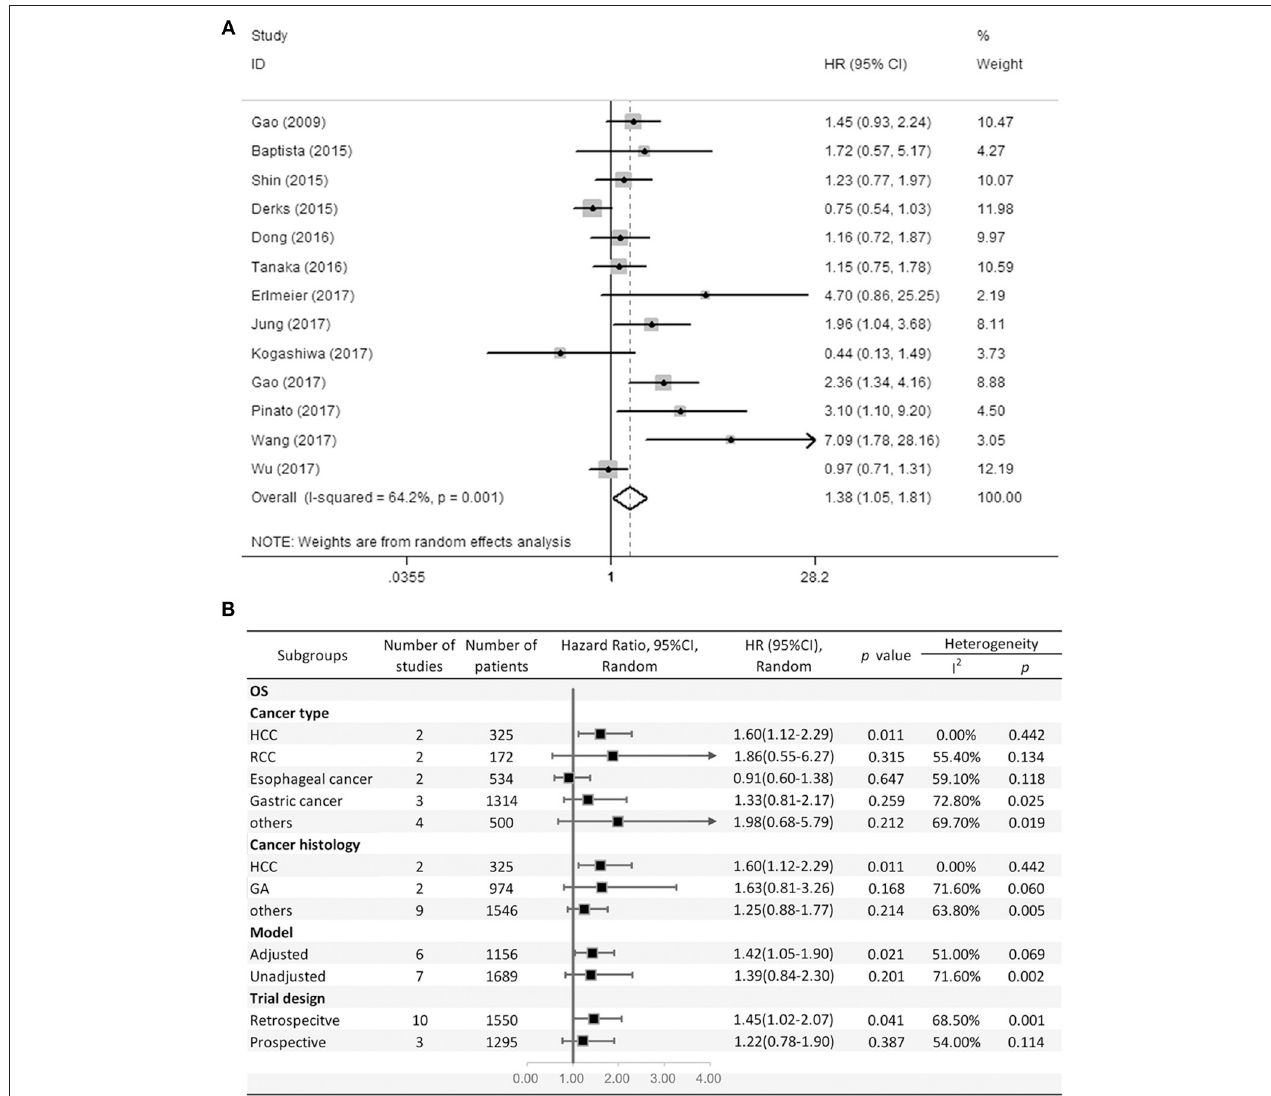
FIGURE 2 | (A) Meta-analysis of the association between PD-L2 expression and OS among solid cancer patients after surgery; (B) Subgroup analyses of the correlation between PD-L2 and OS.